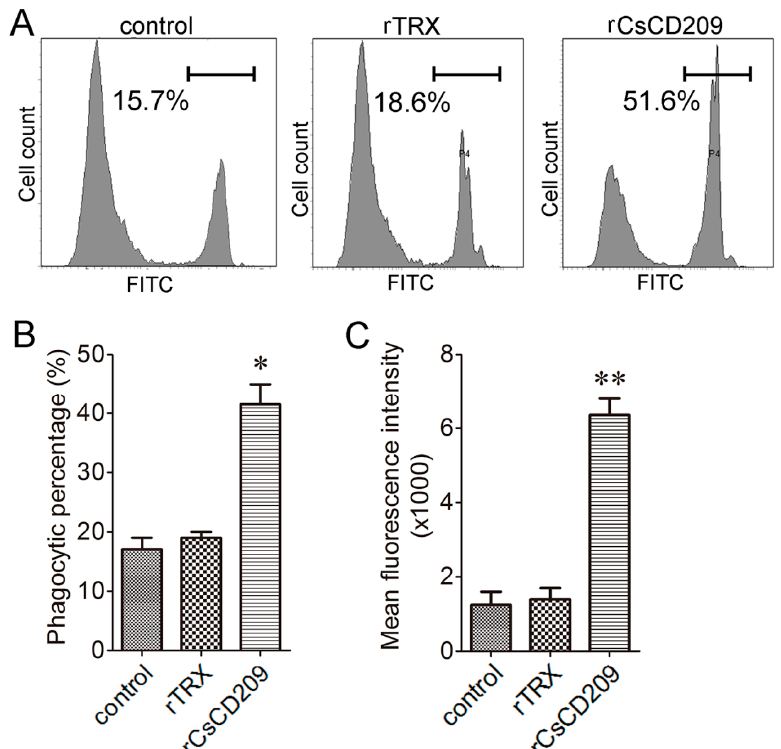
Figure 9. rCsCD209 enhanced phagocytosis of bacteria. Head kidney leukocytes were incubated with fluorescein isothiocyanate (FITC)-labeled Edwardsiella tarda that had been pre-incubated with rCsCD209 or rTrx. Phagocytosis activity was measured by flow cytometry ( A ); Phagocytic percentage ( B ) and phagocytic index ( C ) were statistically calculated. Results are means ± SEM ( n = 5), * p < 0.05, ** p < 0.01.